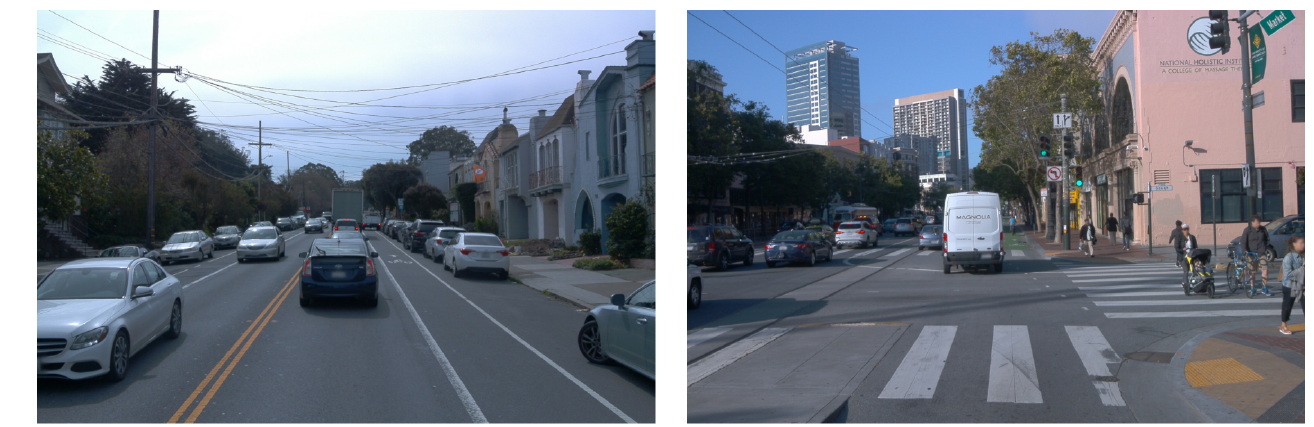
Figure 1. Example camera images from the Waymo Open Dataset.